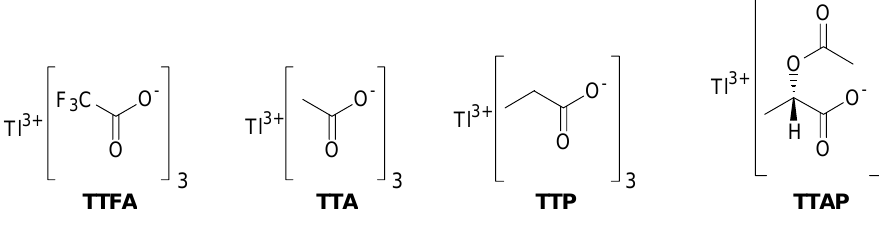
Figure 1. Structures of thallium(III)